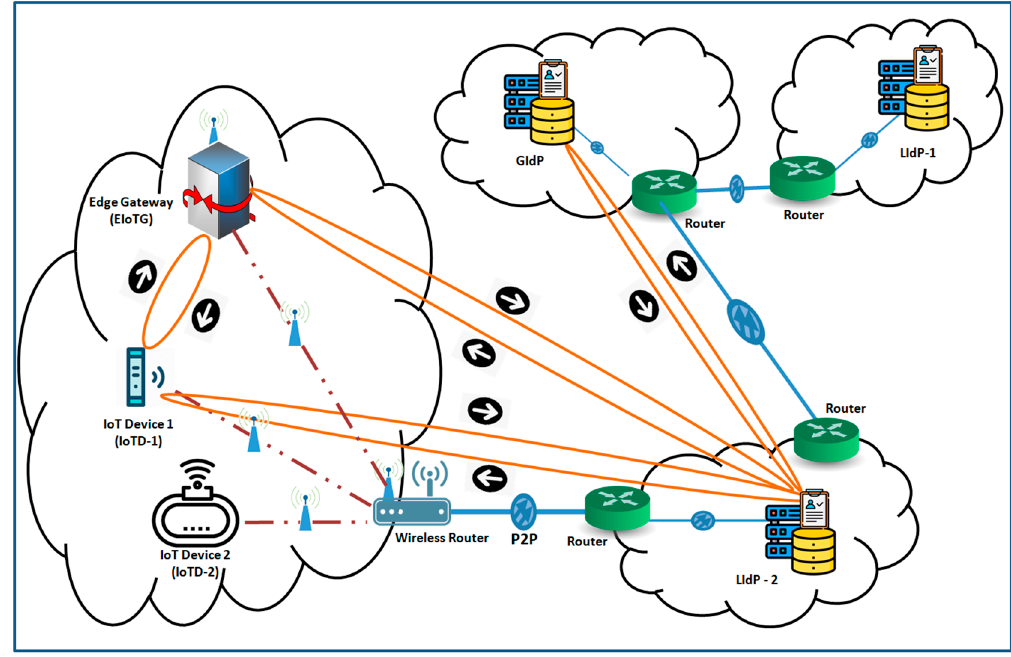
Figure 15. Identity management via LIdP and GIdM when IoTD and IoTG are at same network.